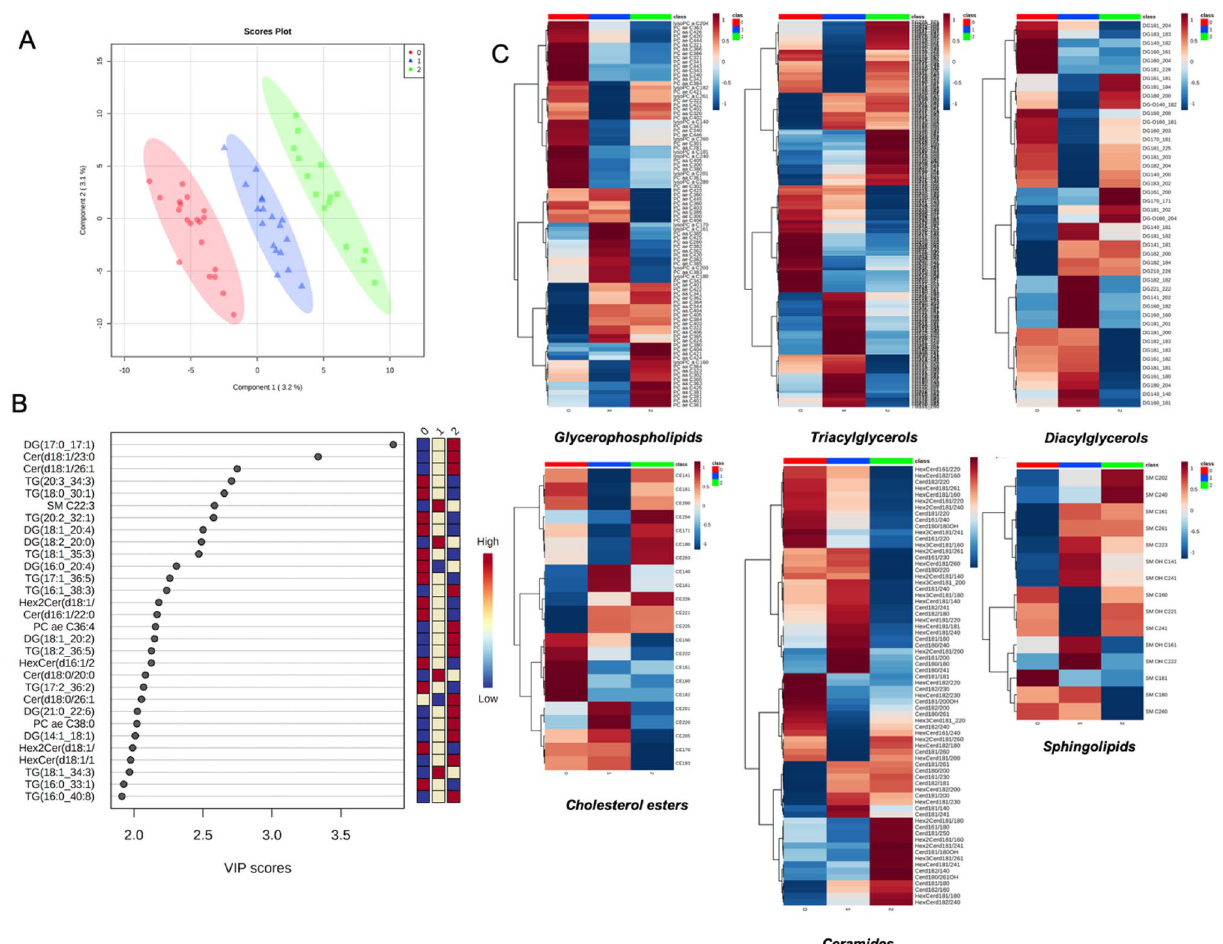
Figure 1. Lipid profiles in COVID-19 patient serum. ( A ) Supervised partial least squares-discriminant analysis (PLS-DA) score plot and ( B ) discriminant lipidic features according to the variable importance on projection (VIP) score of mild, moderate and severe COVID-19 patients. The top 30 important lipids (VIP score ≥ 2.0 were summarized according to their VIP score value. The intensity of the colored boxes indicates the relative lipids abundance in each group (0 mild, 1 moderate and 2 severe patients). ( C ) Heatmaps of the auto-scaled mean lipid concentrations of each patient groups (0 mild, 1 moderate and 2 severe patients) of significantly altered lipids ( p < 0.05) in six different lipid classes. The heatmap color code represents the relative lipid abundance. The concentrations of the metabolites were imputed, log(2) transformed, and Pareto